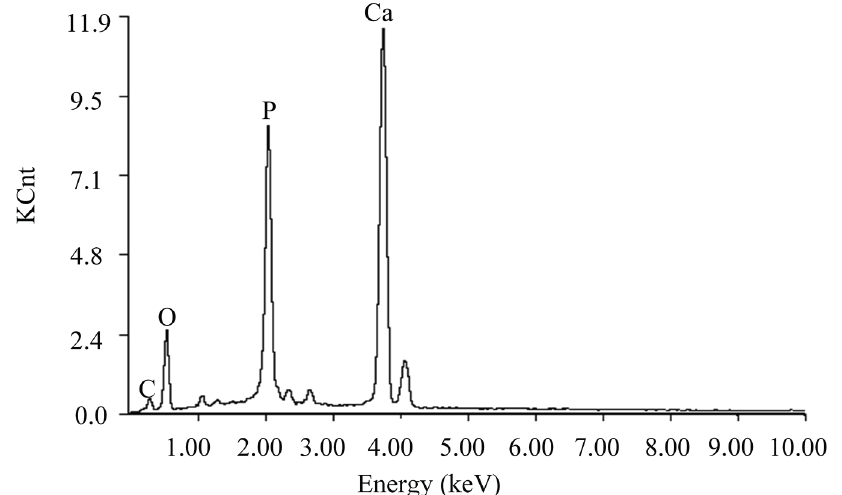
Figure 5. Energy dispersive spectrometer (EDS) analysis of the mineral layers on the scaffold surface after immersed in